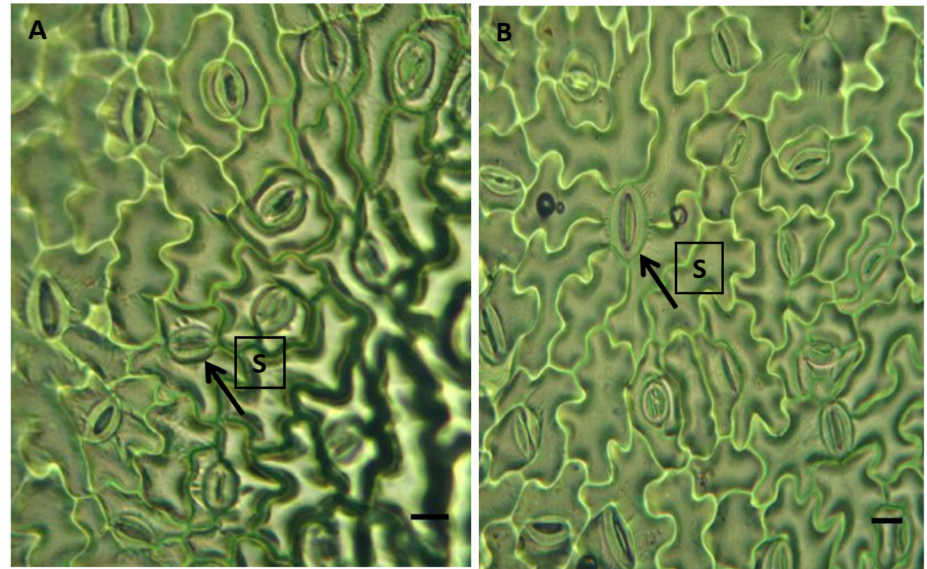
Figure 3. Microphotograph of stomata (S) in a leaf of Phaseolus vulgaris L. ( A ) Plants grown without magnetically treated water (control). ( B ) Plants grown with magnetically treated water (MTW). A 40 × magnification. Bright field optical